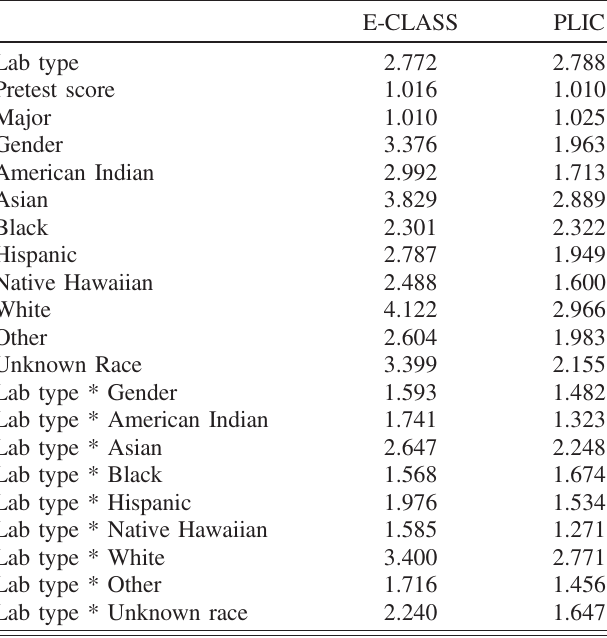
TABLE IX. Generalized variance inflation factors corrected for degrees of freedom (GVIF 1 = 2 df ) for linear mixed models pre- sented in the main text. Values roughly indicate the ratio of the standard error for a variable relative to the standard error for a model with only that variable